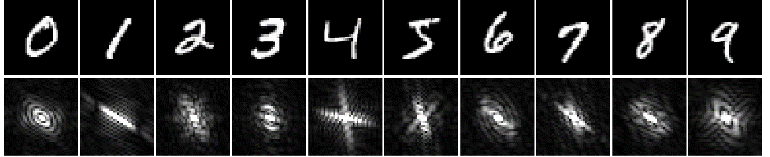
Figure 3. Digit images in the first row and their corresponding frequency images in the second row where they share the bright center area.